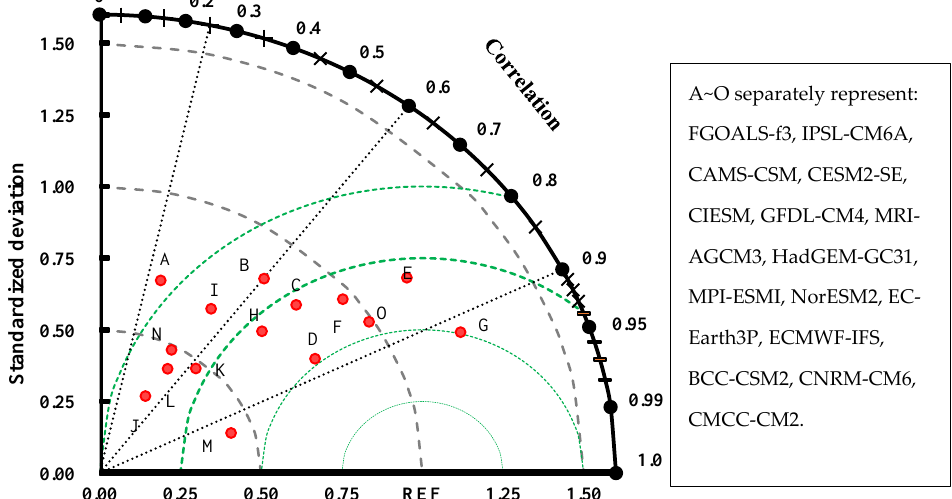
Figure 9. Taylor diagram for the annual mean precipitation from CMIP6 models and observations in TP. The radial coordinate is the magnitude of the standard deviation (denoted by black arcs). The concentric green semi-circles denote root-mean-square differences. The angular coordinate shows the correlation coefficient (denoted by dotted black lines).